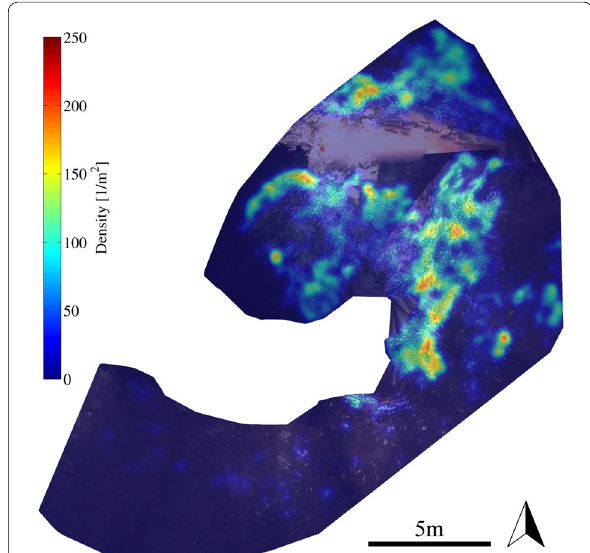
Fig. 12 Top view of the 3D reconstruction of the area around the NBC natural hydrothermal chimney with the density map of S. crosnieri overlaid